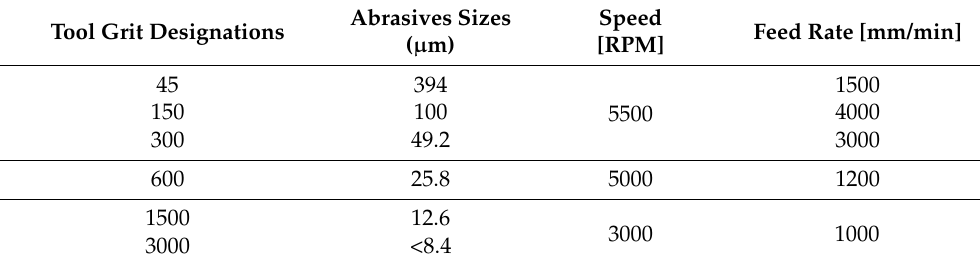
Table 2. Maximum cutting parameters prescribed for each edge grinding tool used (adapted from GranQuartz Canada Inc.)